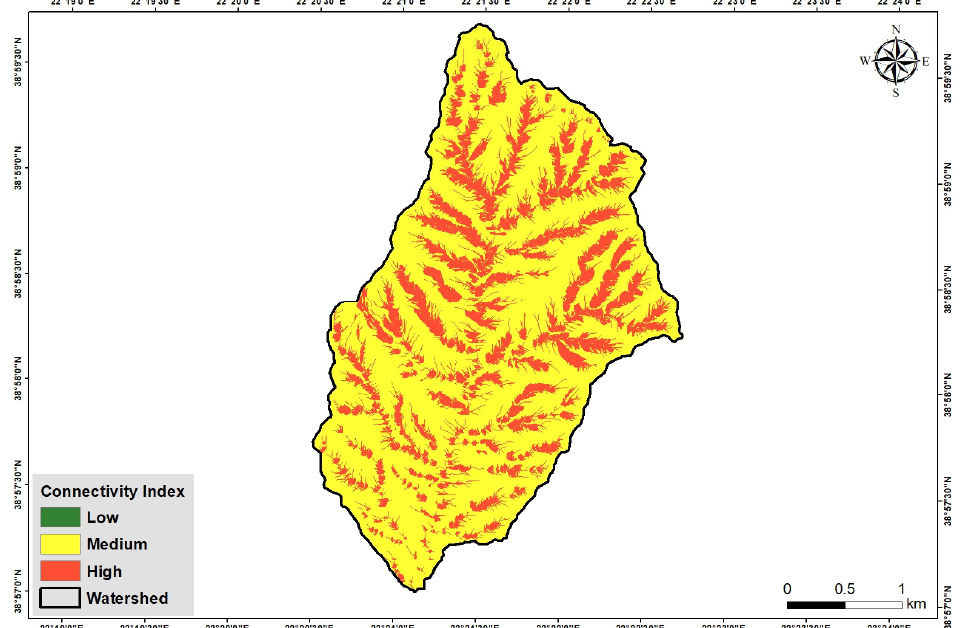
Figure 6. Connectivity Index map, showing medium and high connectivity across the study area, resulting in the absence of significant sinks, and the rise in soil erosion